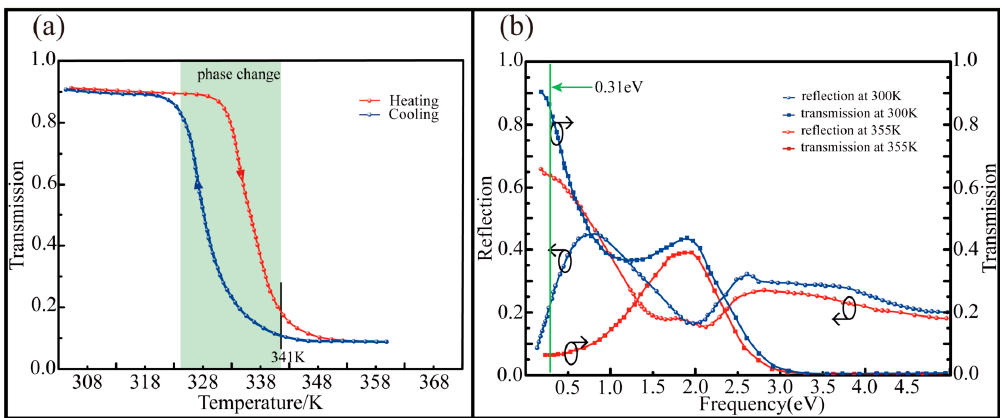
Figure 2. Optical properties of VO 2 film [39]. ( a ) The transmittance of the VO 2 film at 4 μ M varies with temperature, and the red line and the blue line represent the heating and cooling process, respectively; ( b ) the bi-phase transmittance and reflectance of VO 2 film in a range of 0.25 eV to 5 eV frequency.